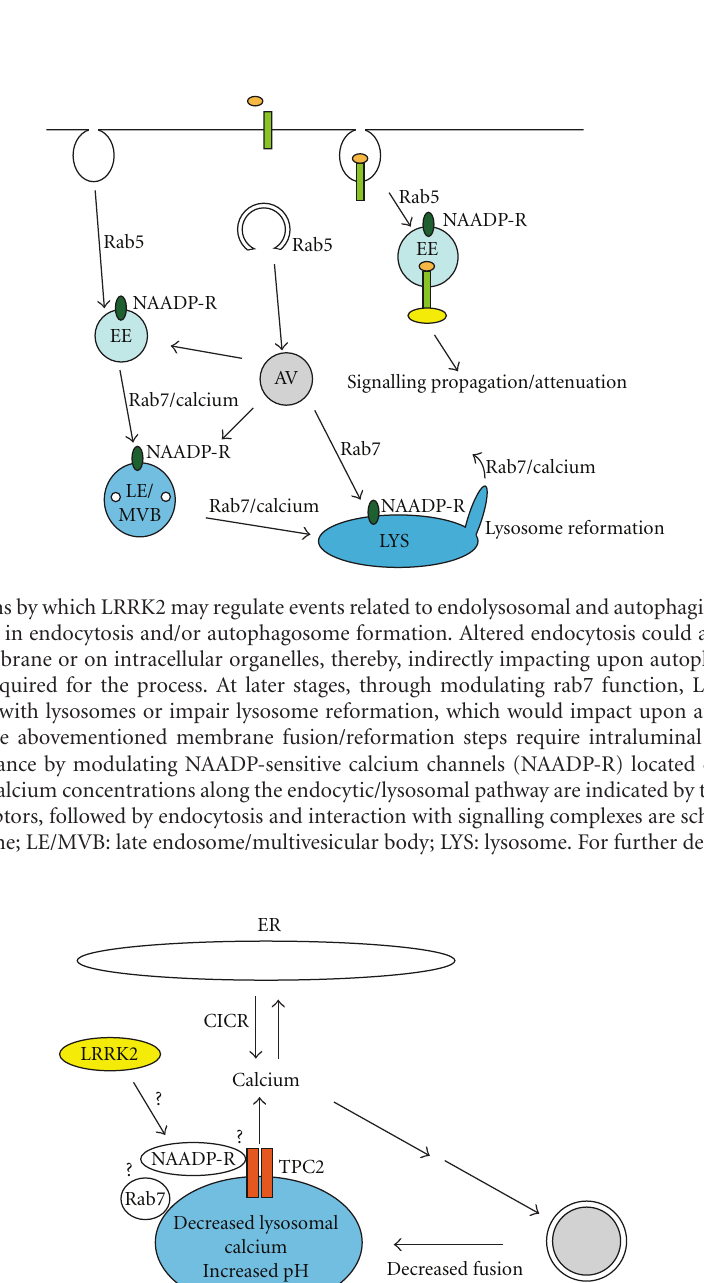
membrane fusion events, thus, directly impacting upon endosomal and autophagic tra ffi cking events